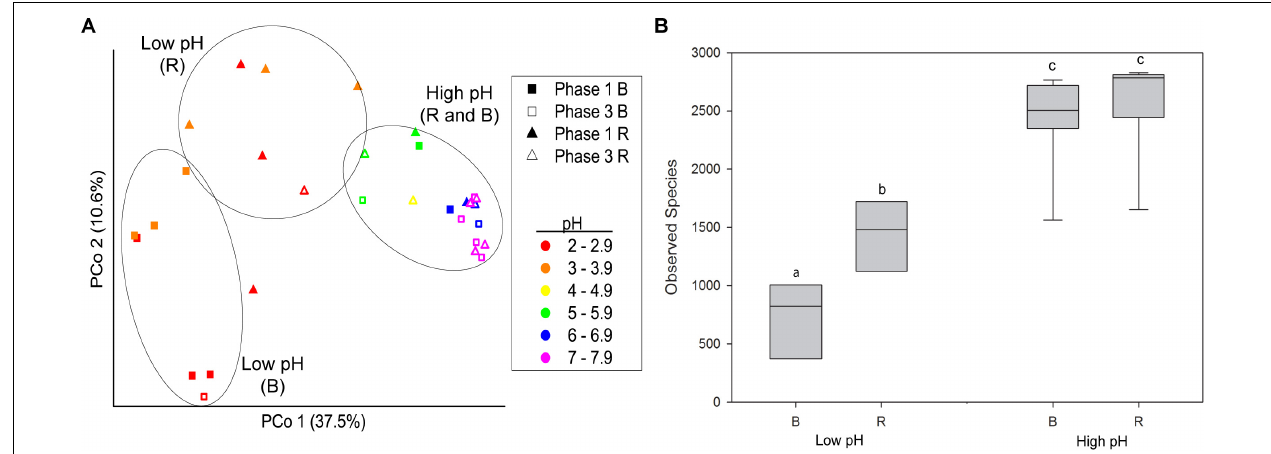
FIGURE 1 | (A) Beta diversity of bacterial communities from buffalo grass bulk and rhizosphere substrate collected from Phase 1 and Phase 3 represented as a PCoA plot of unweighted UniFrac distances between all samples. Samples from rhizosphere at low pH ( < 4), bulk at low pH, and rhizosphere and bulk at high pH ( > 4) form three distinct groups ( p < 0.05, PERMANOVA), as indicated by black circles. (B) Alpha diversity of microbial communities from buffalo grass bulk and rhizosphere samples from high pH ( > 4) and low pH ( < 4) substrate. Different letters indicate significant difference (ANOVA, Tukey’s HSD, p < 0.05). B, bulk; R,